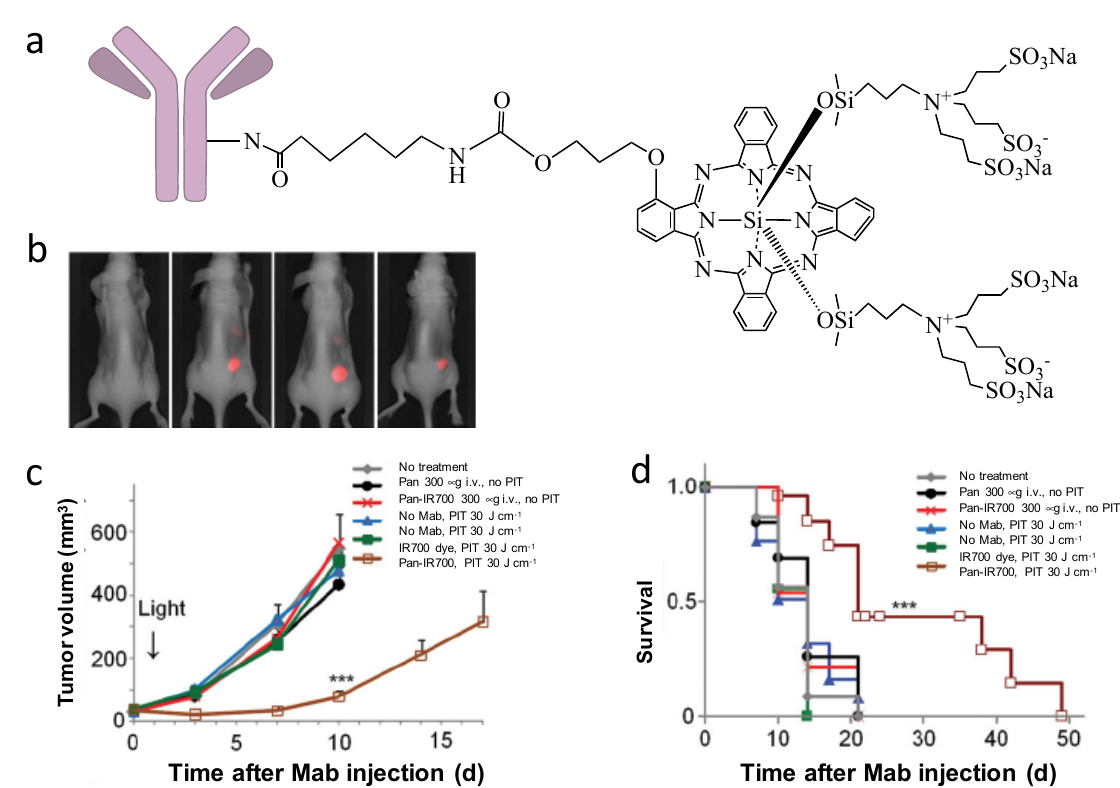
Figure 3. ( a ) General structure of antibody-based IR700 conjugates for NIR-PIT. ( b ) Pan-IR700 selectively accumulate in EGFR-expressing A431 tumors (right), but not in EGFR-non-expressing 3T3 tumors (left). ( c ) PIT with Pan-IR700 significantly inhibited A431 tumor growth. ( d ) PIT with Pan-IR700 significantly prolonged animal survival time. (***: p < 0.001). Reprinted with permission from Ref. [62]. Copyright 2011 Springer Nature. Table 2. Summary of IR700-based